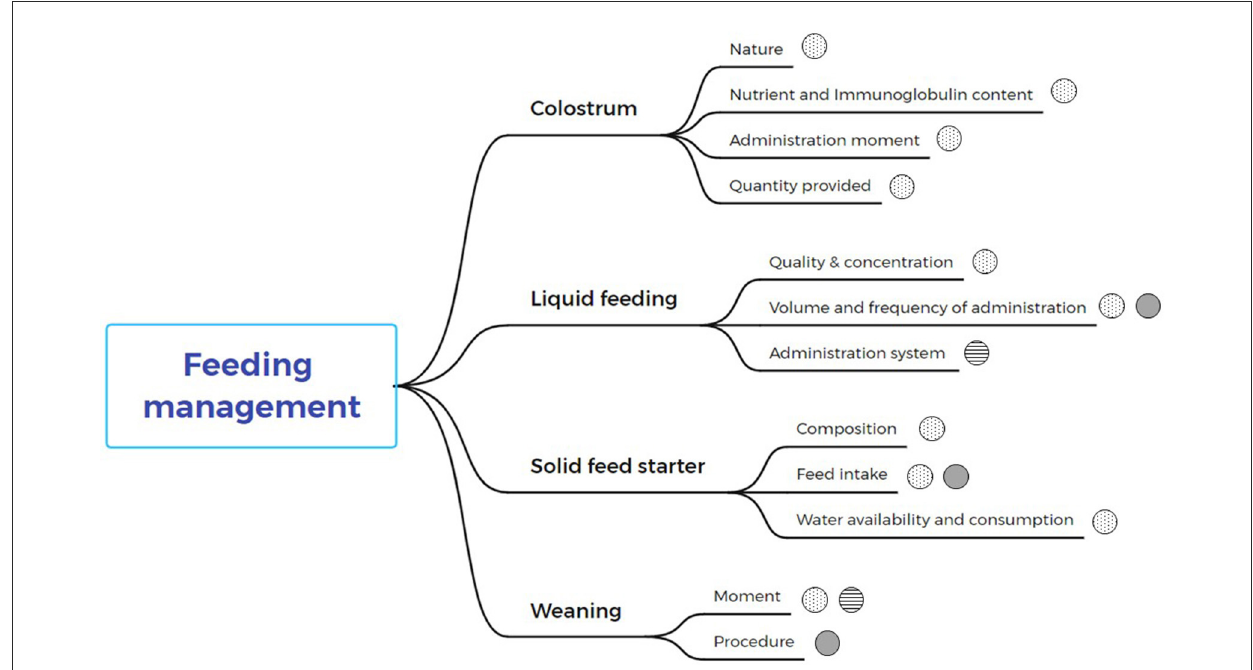
FIGURE5 Critical points of each phase of feeding management are identified and their relationship to animal welfare spheres. Dotted spheres represent biological function and health, spheres with horizontal lines relate to natural living, and gray spheres relate to affective states or cognitive judgement.